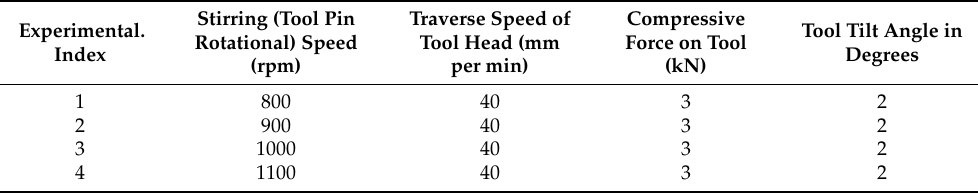
Table 3. Friction stir processing parameters used.